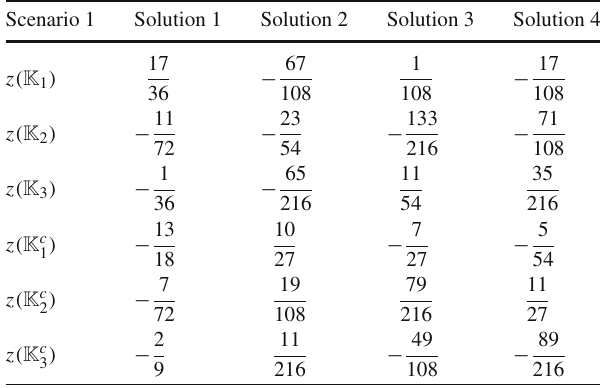
Table 21 The same as in Table 17, but with the minimal number of singlets under the SM gauge group n ν c = 3 , n S = 2 , n N = 1 and